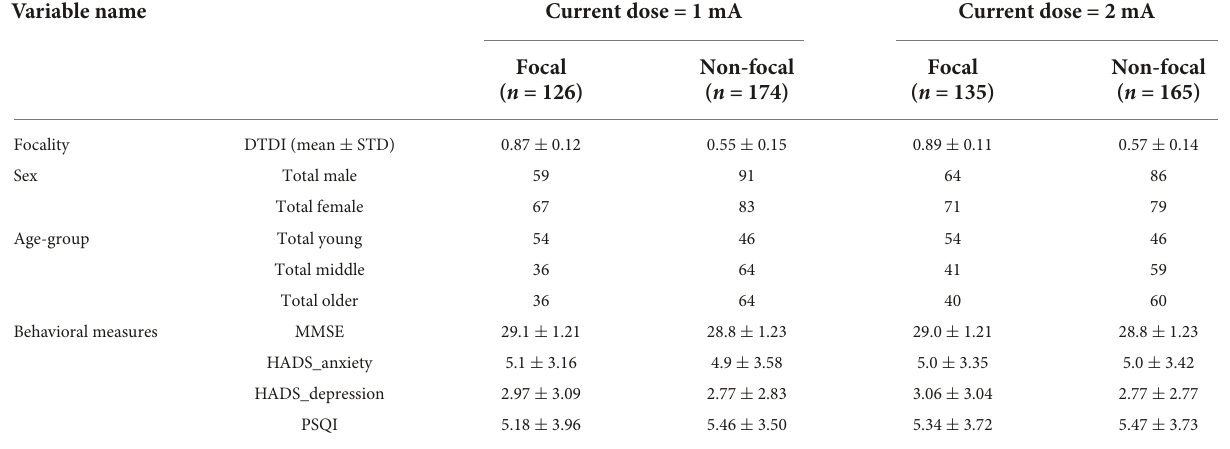
TABLE 2 Same as Table 1 for the montage location CP5-Cz with two current doses (1 and 2